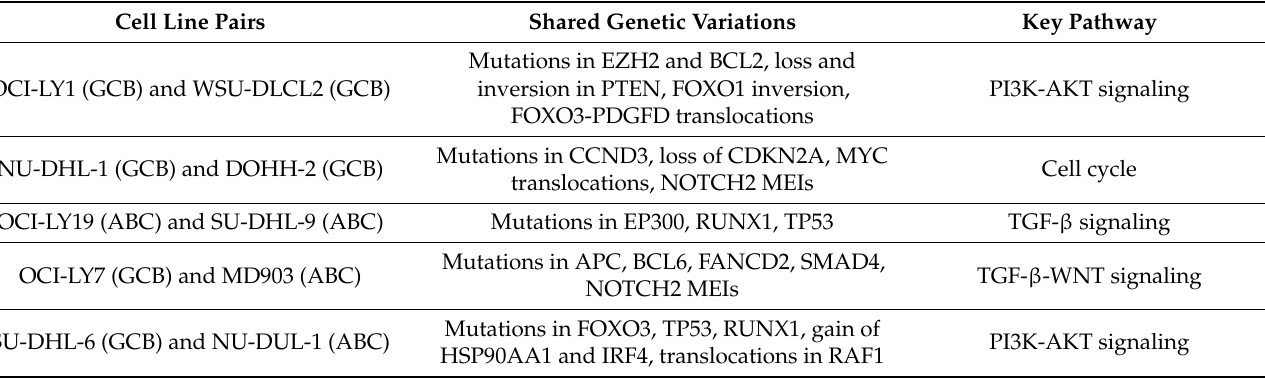
Table 3. Probable subgroups within and between DLBCL subtypes observed in cell lines based on shared genetic